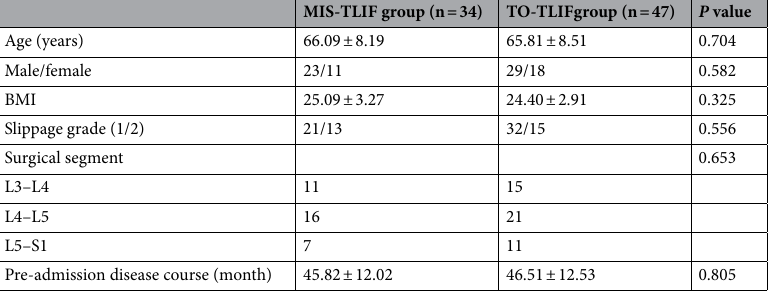
Table 1. Baseline characteristics of the